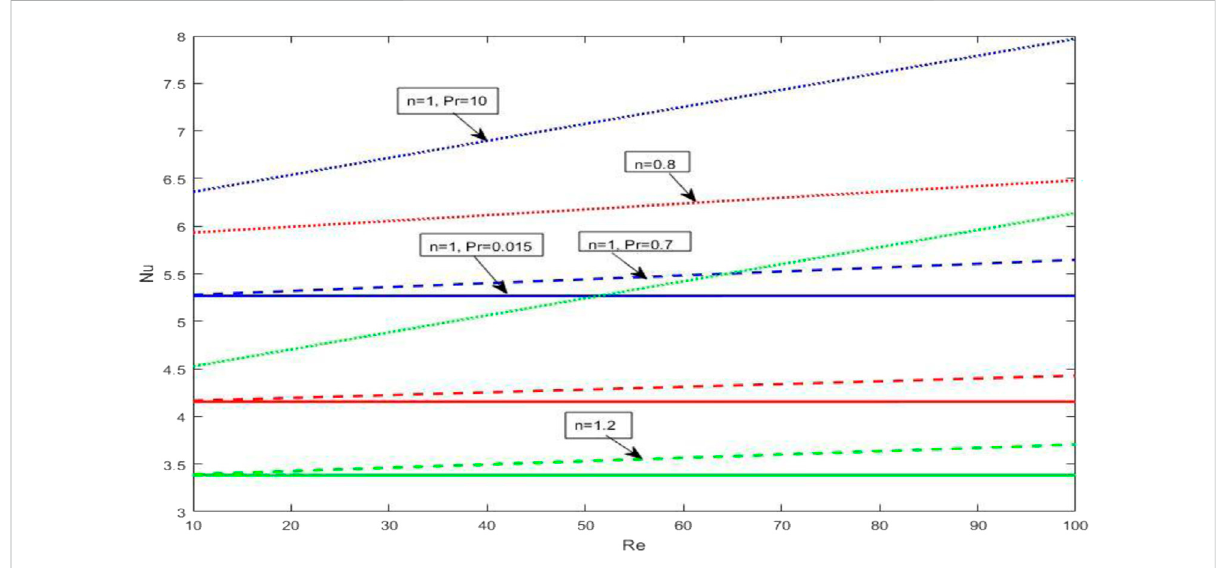
FIGURE 17 Variation in the local Nusselt number ( Nu Local ) against the Reynolds number ( Re ) .